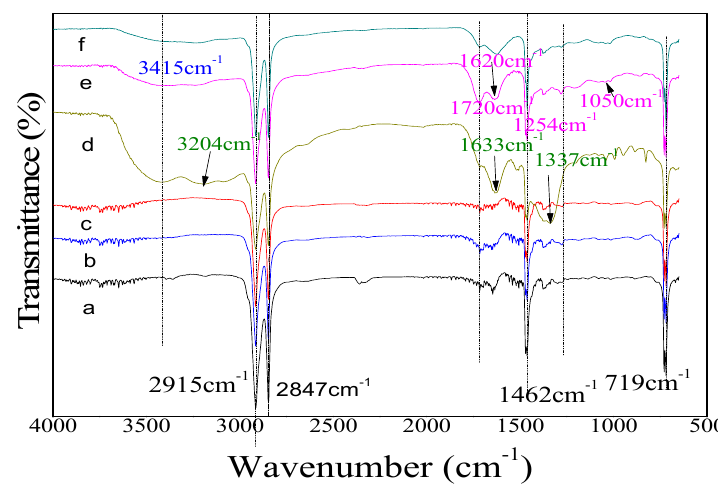
Figure 5. ATR-FTIR spectroscopy of PE ( a : pristine PE) and PES after DBD pre-treatments ( b : Ar plasma; c : O 2 plasma; d : Ar+allylamine; e : Ar+acrylic acid; f : Ar+ethanol).